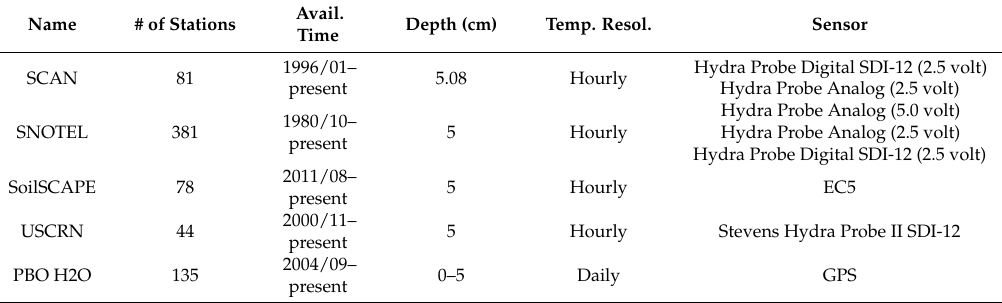
Table 1. Characteristics of the four in-situ networks (the Soil Climate Analysis Network (SCAN) network, the SNOwpack TELemetry (SNOTEL) network, the Soil moisture Sensing Controller and oPtimal Estimator (SoilSCAPE) network, and the U.S. Climate Reference Network (USCRN) network) and one Global Navigation Satellite System interferometric Reflectometry (GNSS-R) network (the PBO H2O